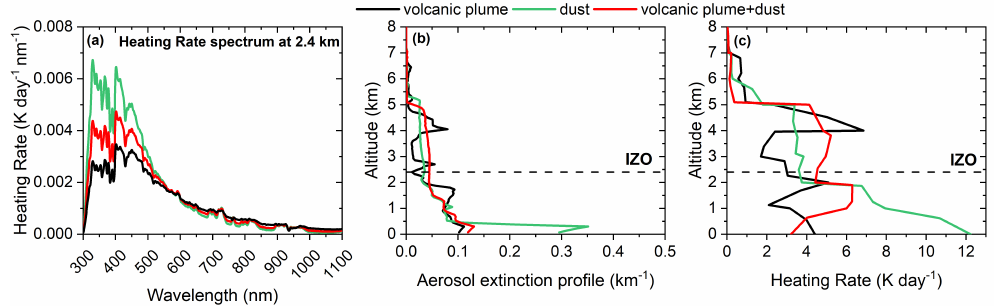
Figure 10. ( a ) Aerosol heating-rate spectrum (Kday − 1 nm − 1 ) at 2.4 km a.s.l. (IZO altitude). Vertical profile of ( b ) aerosol extinction coefficient (km − 1 ) extracted from the MPL at 523 nm at the SCO and ( c ) heating rate (Kday − 1 ), integrated between 300 and 1100 nm, for the volcanic plume (black), dust (green), and volcanic plume + dust (red). The dashed line indicates the IZO